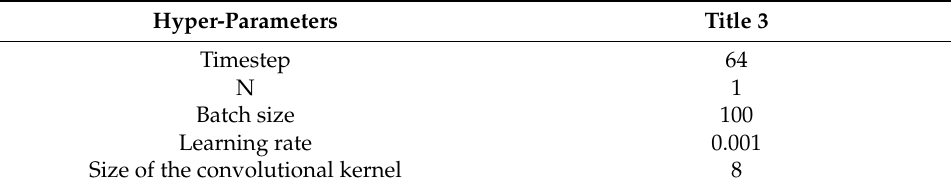
Table 3. The hyperparameter table of the variable screening